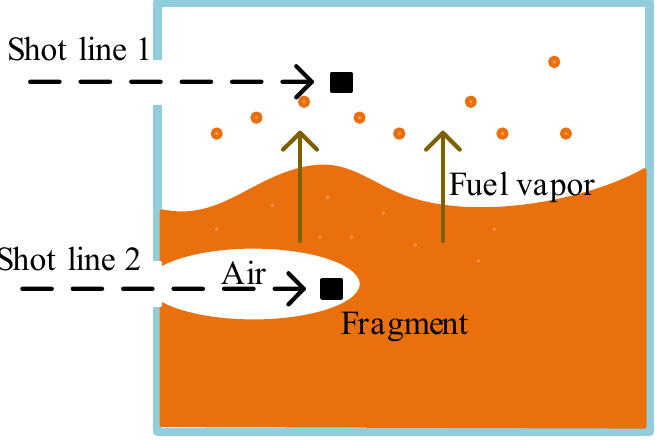
Figure 12. Gas changes after the fragment entered the fuel tank.